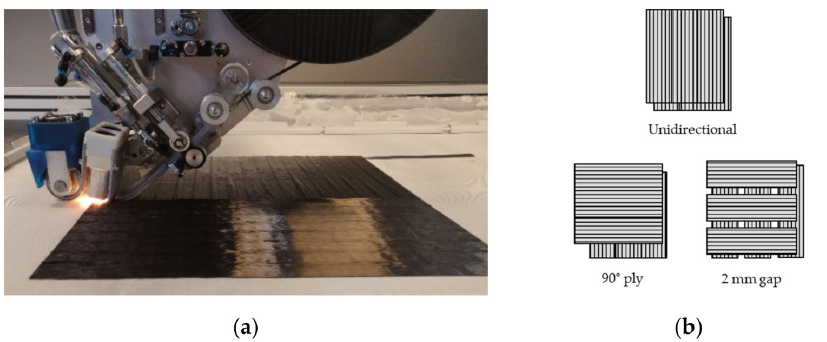
Figure 8. ( a ) DFP deposition of a preform configuration without gaps and 0 ◦ and 90 ◦ plies; ( b ) schematic of preform configurations.